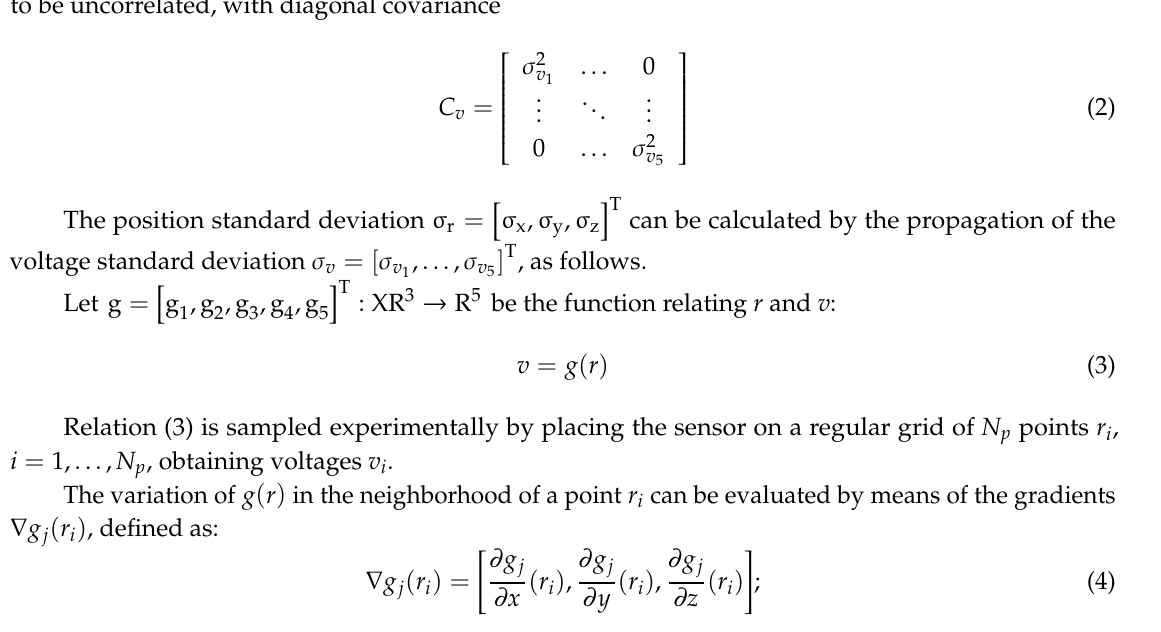
Figure 5. Voltage induced in the coil sensor and current measured with a multimeter—channel 3.